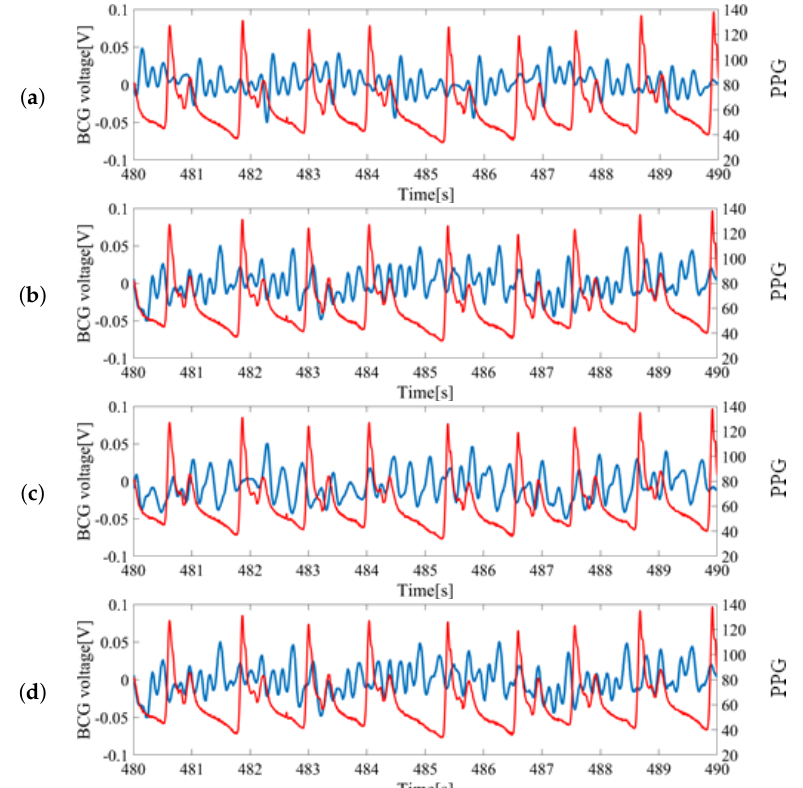
Figure 3. Sample data of raw sensor inputs measured from a subject lying on the back: ( a ) Ballistocardiogram (BCG) signal from S1 vs. photoplethysmography (PPG) signal; ( b ) BCG signal from S2 vs. PPG signal; ( c ) BCG signal from S3 vs. PPG signal; ( d ) BCG signal from S4 vs. PPG signal. Blue colored signals correspond with the measurement from bed leg sensors and red colored signals (finger pressure) correspond to the PPG signal from the pulse